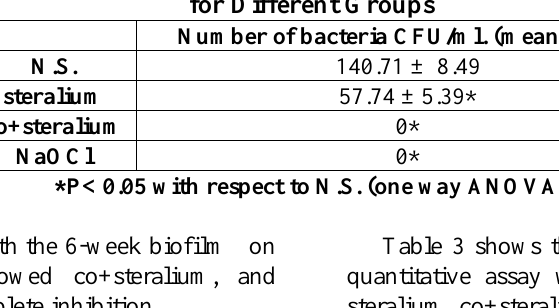
Table 2: Quantitative Analysis of Three-Week E. Faecalis Biofilm Formed on Tooth Substrate